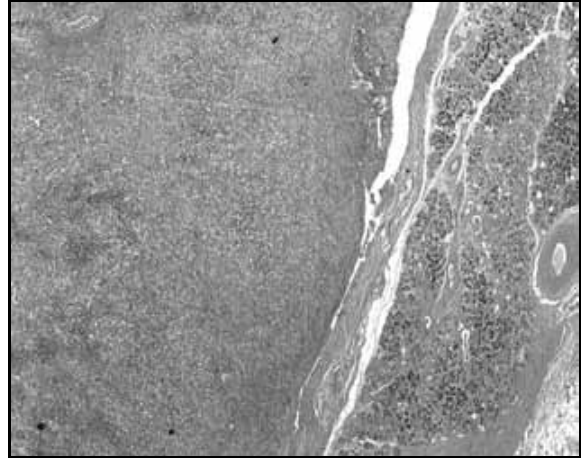
Figure 3 – A neoplasm with well-defined margins. The photomicrograph depicts the transition between residual parotid gland tissue and the neoplasm (HE, 20× magnification) HE: hematoxicilin and eosin.